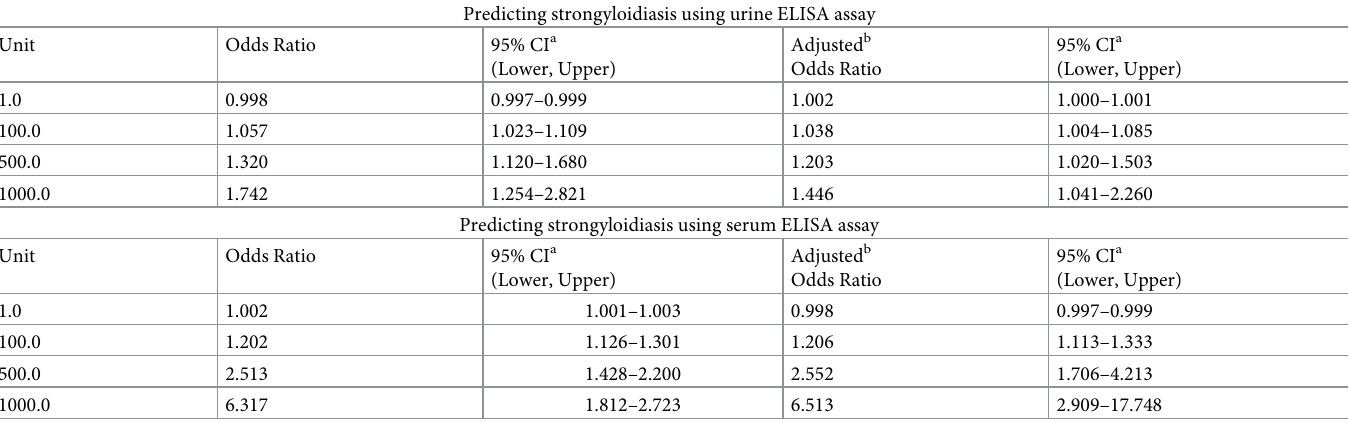
Table 3. Odd ratios and 95% confidence intervals for predicting the presence of Strongyloides stercoralis infection by the detection of IgG against a crude S . ratti antibody in urinary or serum. Predicting strongyloidiasis using urine ELISA